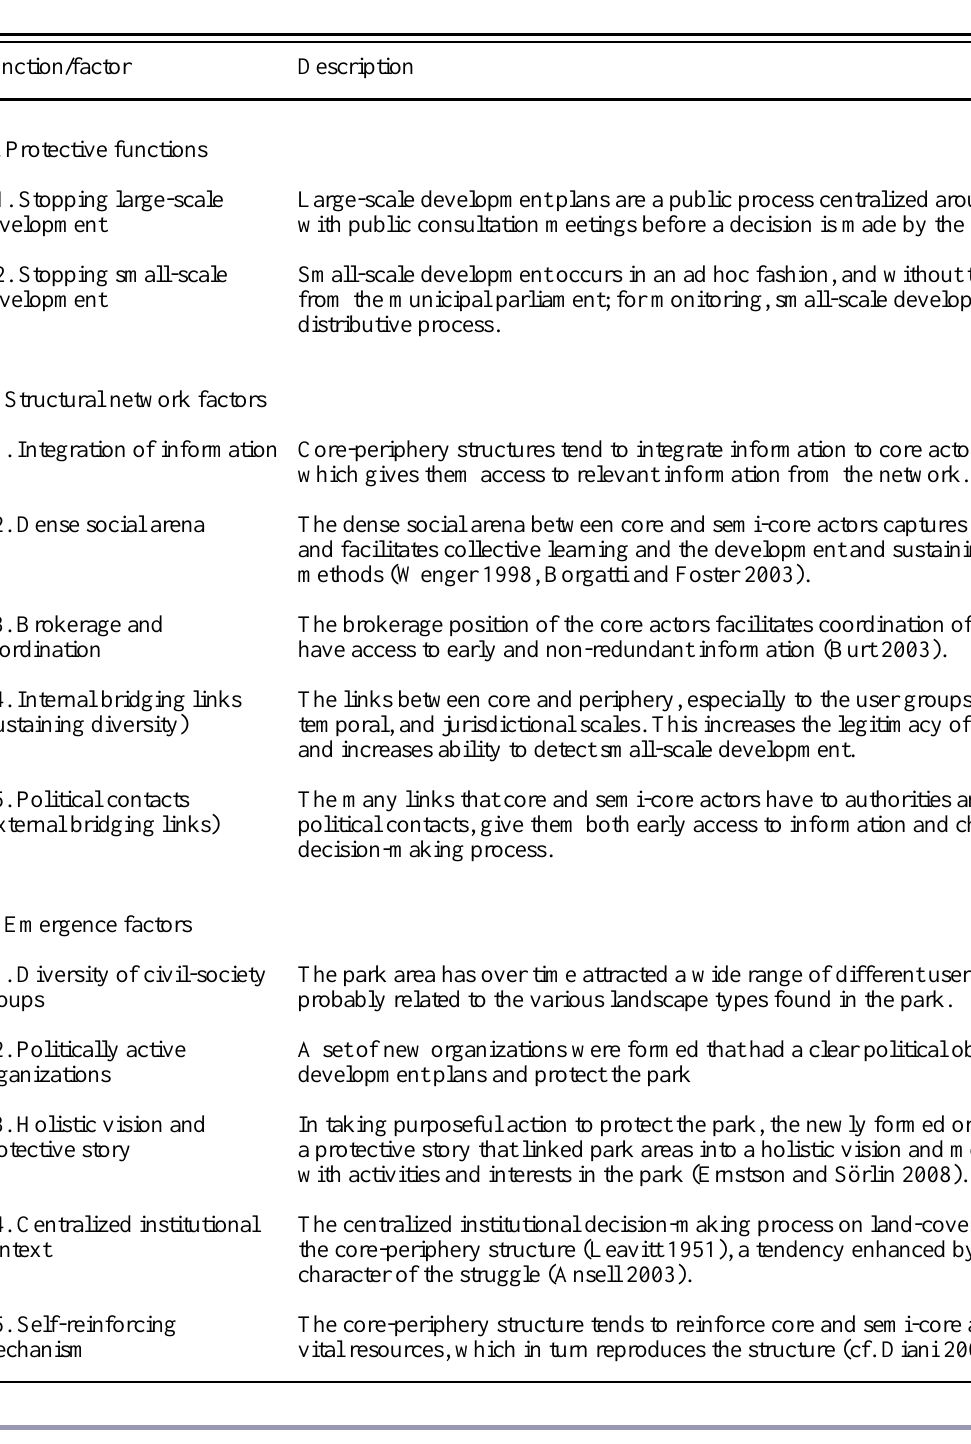
Table 3. This table summarizes our findings in the following way: the Ecopark movement upholds two protective functions (A), which are facilitated through five structural network factors (B). There are further five factors that can explain the emergence and reproduction of this structure (C). The table can be read as follows: C has given rise to B, which in turn sustains